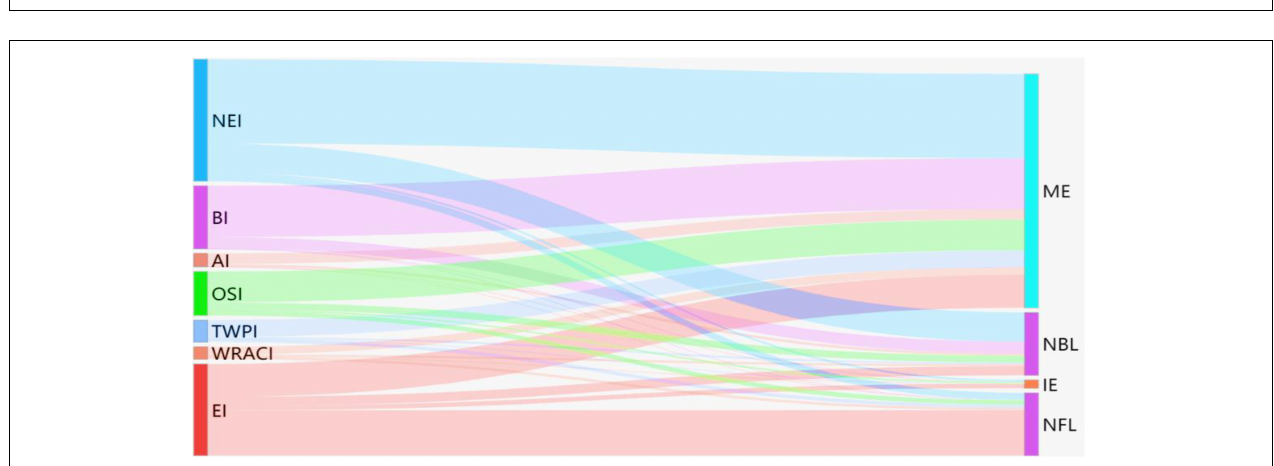
FIGURE 4 | Implicit net energy transfer between energy industries in Shaanxi Province in 2017.